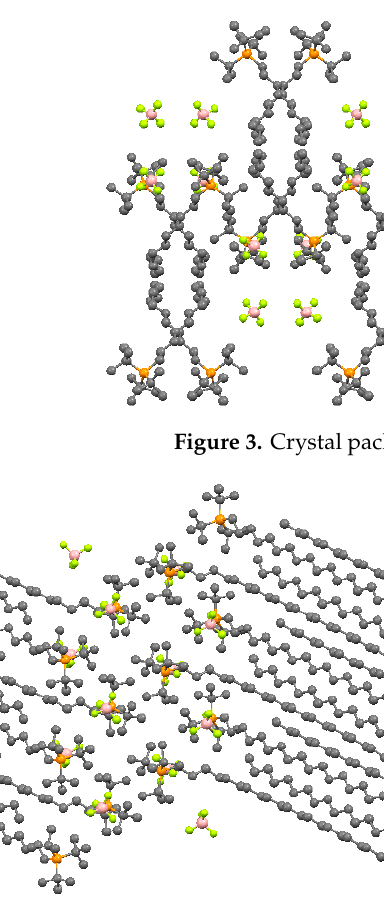
Figure 4. Crystal packing of 10b .